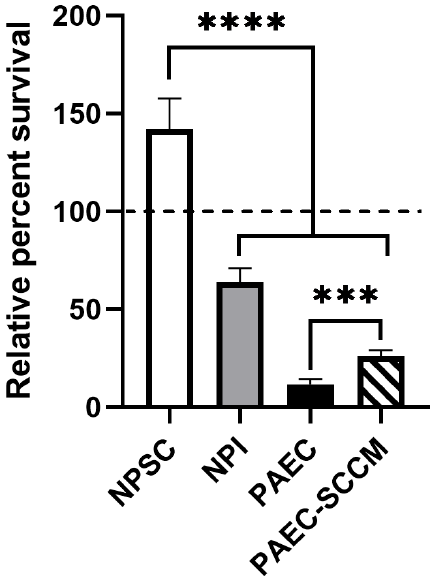
Figure 2. NPSC survival in human complement in vitro. NPSCs (white bar) survive at 141.8 ± 6.5% after exposure to activated human complement serum for 90 min while NPI (gray bar) and PAEC (black bar) controls are diminished to 64 ± 4.0% and 11.7 ± 1.4%, respectively. PAECs cultured in media collected from NPSCs (PAEC-SCCM, striped bar) survive human complement in vitro at about 25.9 ± 1.6%. Results were normalized to media-only controls of 100% (dashed line). Statistical significance was determined with unpaired t-test with two-tailed p -value. *** p < 0.001. **** p < 0.0001.